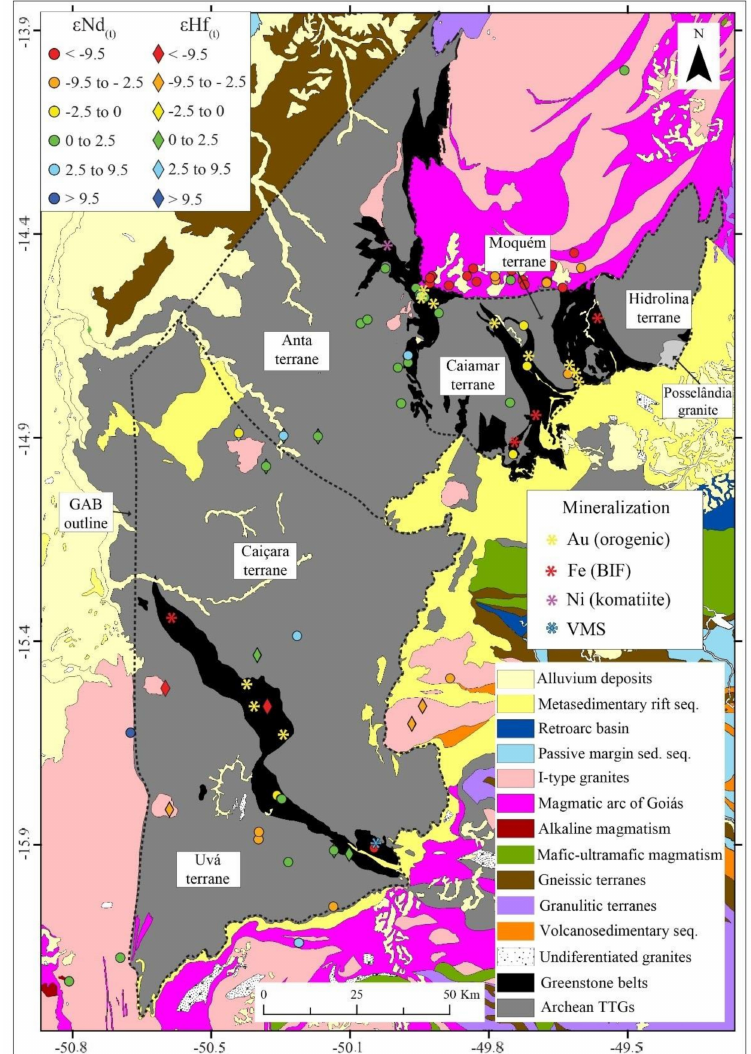
Figure 9. Map showing available ε Nd and zircon ε Hf dataset in the Goi á s Archean Block. The diachronous stabilization of TTGs is evidenced by crustal growth migration towards the east in the northern GAB, suggested by increasingly crustal input eastward, whereas dominant juvenile TTG crust in the south. References for isotopic data: [22–25,28,75,147,152] and this